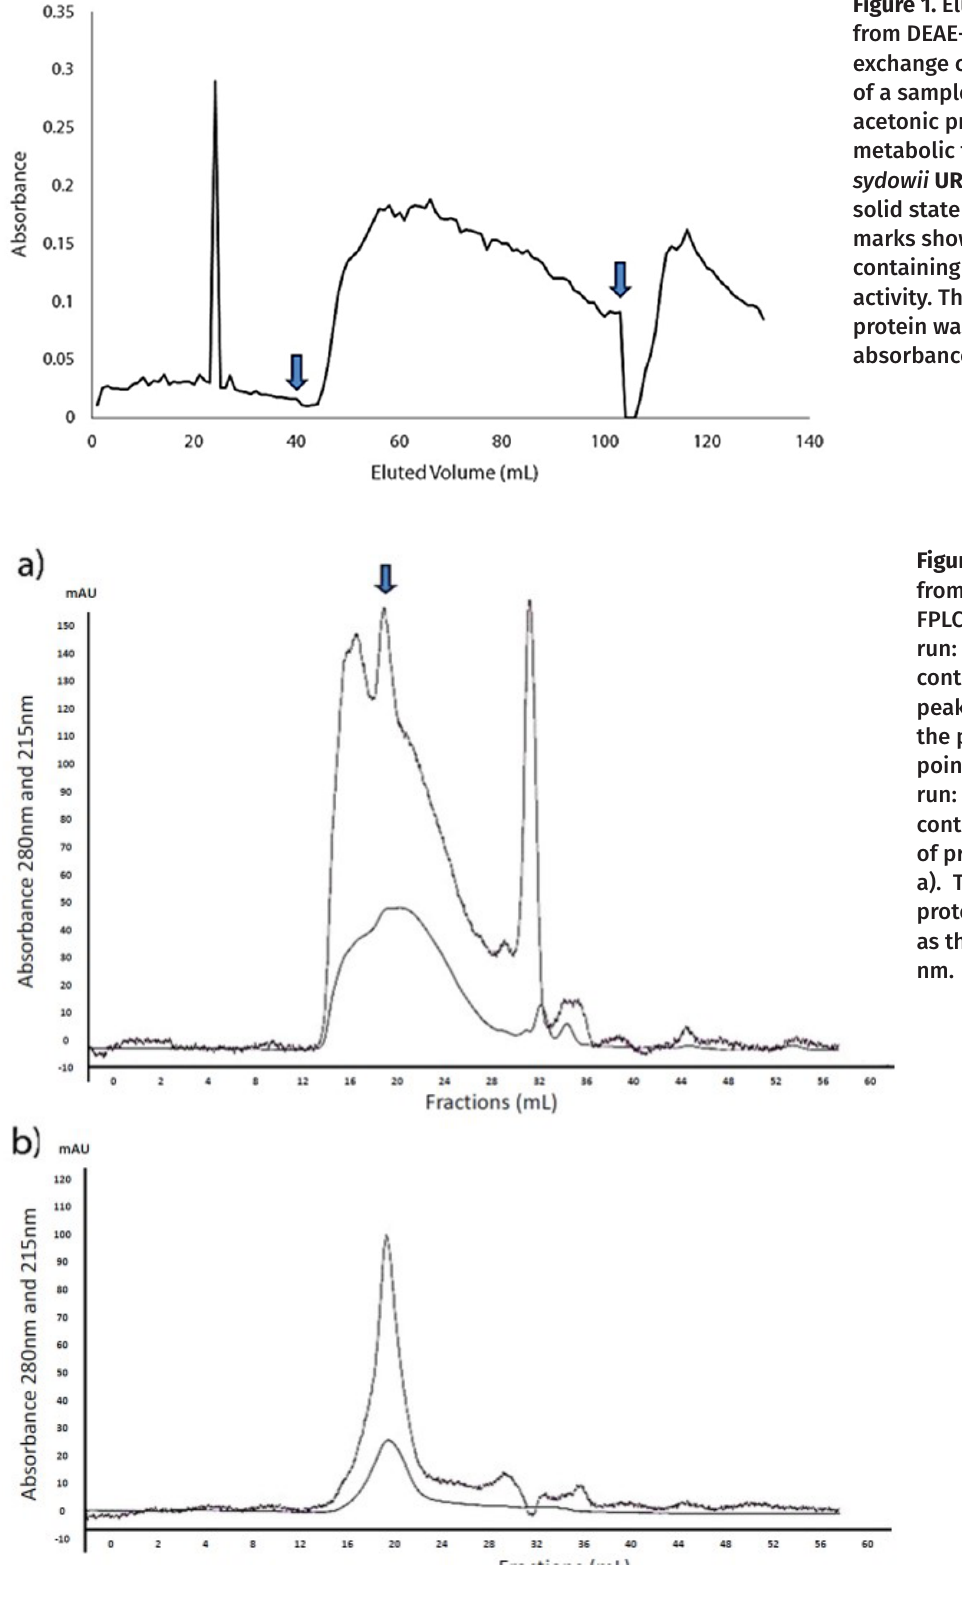
Figure 1. Elution profile from DEAE-Sephadex anion exchange chromatography of a sample obtained from acetonic precipitation of liquid metabolic from Aspergillus sydowii URM5774 extract after solid state fermentation. The marks show the fractions containing the protease activity. The content of the protein was expressed as the absorbance at 280 nm.